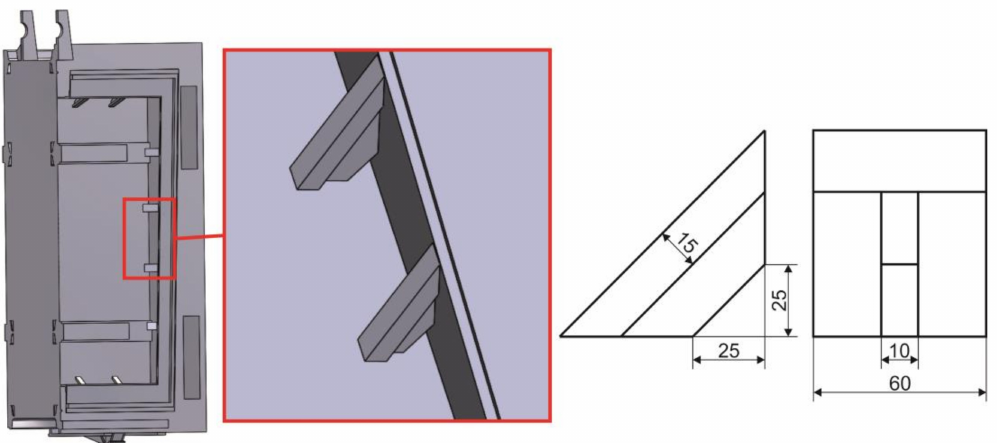
Figure 20. Newly designed reinforcing elements welded to the sealing part of the sluice gate with its basic dimensions.